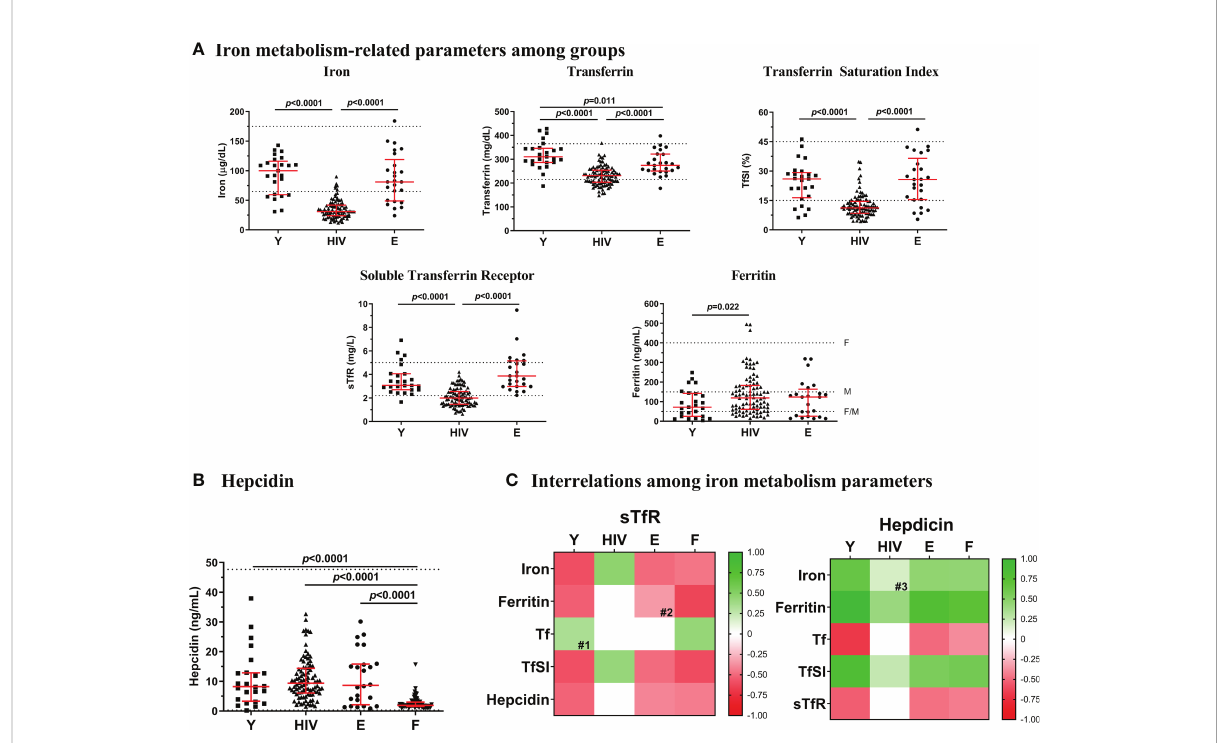
FIGURE 1 Iron-related parameters. (A) Levels of iron metabolism-related parameters (iron, transferrin, TfSI, sTfR and ferritin) in Young non-HIV (Y), HIV, and Elderly non-HIV € groups. (B) Hepcidin levels in Y, HIV, E and F (ferropenic group, with ferritin <50 ng/mL) groups. Comparisons were assessed using nonparametric Kruskal-Wallis/Mann – Whitney U tests. Variables with a p -value <0.05 were considered statistically signi fi cant. Grid lines represent minimum and maximum standard values; F, in females and M, in males. (C) Associations between sTfR or hepcidin and the rest of iron metabolism parameters in Y, HIV, E, and F groups. Color intensity of boxes represents Spearman ’ s rank correlation coef fi cient value as indicated in the color legend. All colored boxes represent statistically signi fi cant correlations, excepting for those noted as # (0.05 ≤ p ≤ 0.1). White boxes represent correlations with p -values >0.1. #1, p=0.092; #2, p=0.100; #3, p=0.096. Tf, transferrin; TfSI, transferrin saturation index; sTfR, soluble transferrin